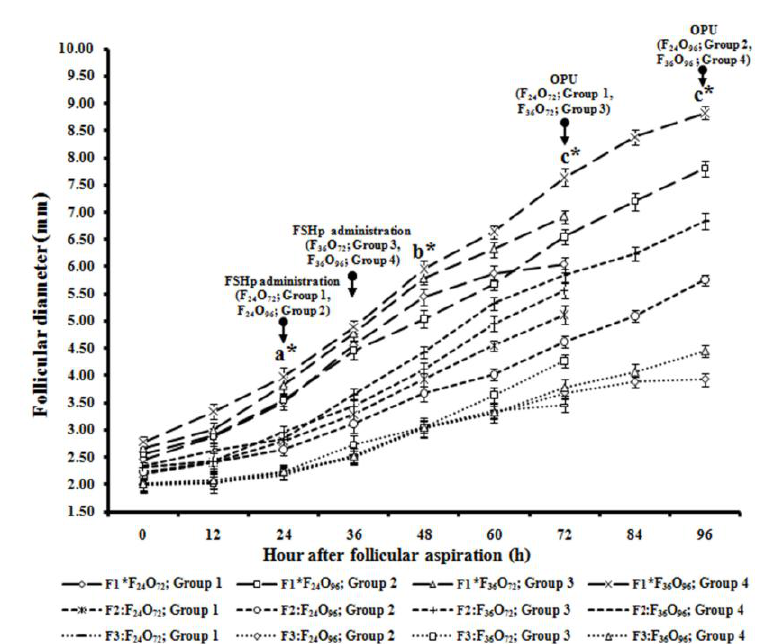
Figure 2. Ovarian follicular dynamics after follicular aspiration under repeated superstimulation of ovarian follicular growth and OPU in Thai native heifer. * Protocol code (Group), a single dose i.m. administration of 100 mg FSHp at 24 h and OPU at 72 (F 24 O 72 ; Group 1) or 96 h (F 24 O 96 ; Group 2), and a single dose i.m. administration of 100 mg FSHp at 36 h and OPU at 72 (F 36 O 72 ; Group 3) or 96 h (F 36 O 96 ; Group 4) after follicular ablation. Each dot represents mean  SEM. Follicles are identified by maximum attained diameter as F1*: largest follicles, F2* coordinate follicle and F3*: subordinated follicle. Values with asterisk (*) indicate significant differences in follicular diameter of F1, F2 or F3 at the time of beginning deviation (a), dominance follicle selection (b) and end of OPU session (c) after follicular aspiration among groups